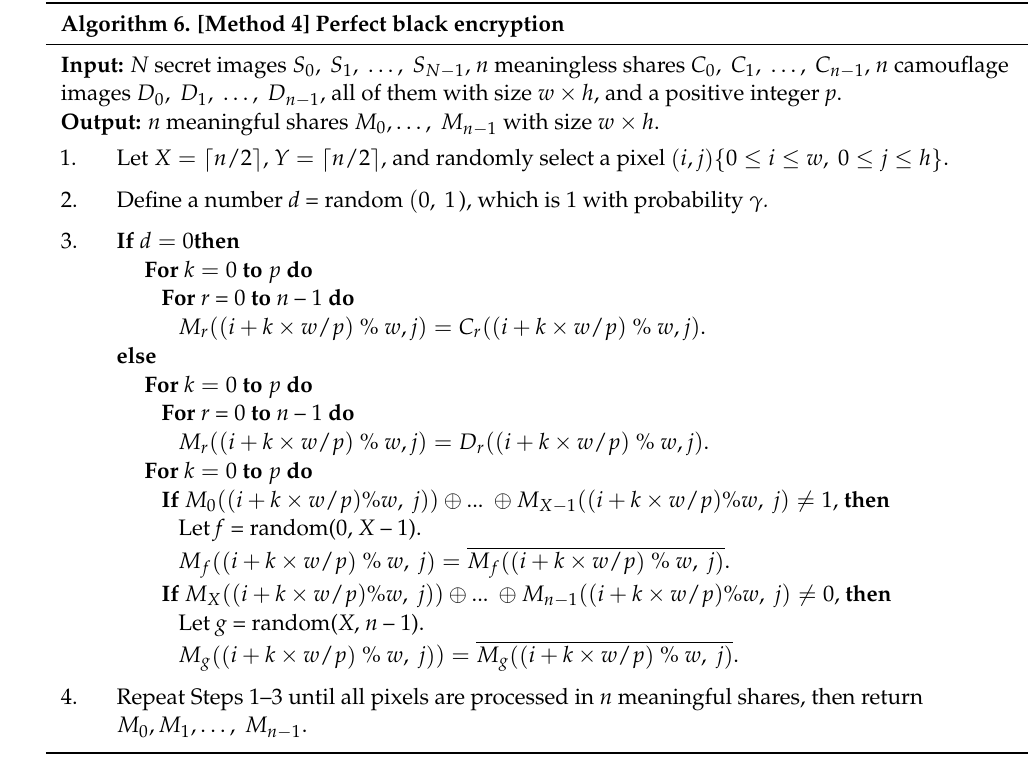
Algorithm 6. [Method 4] Perfect black encryption